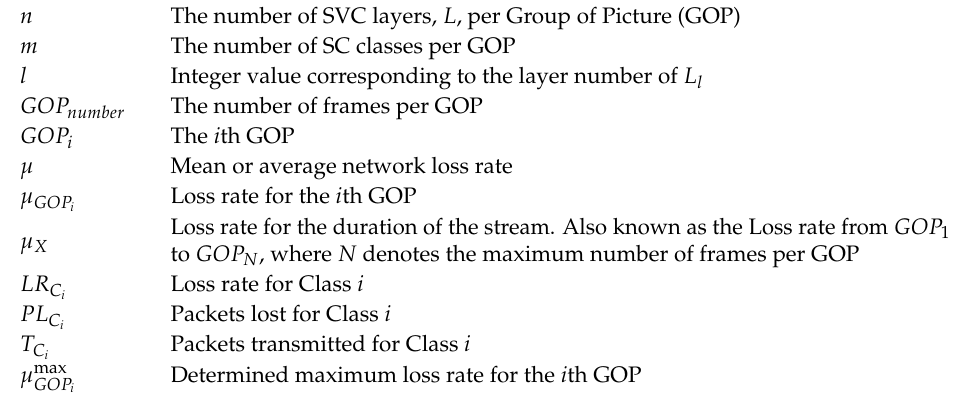
Table 2. Notation and